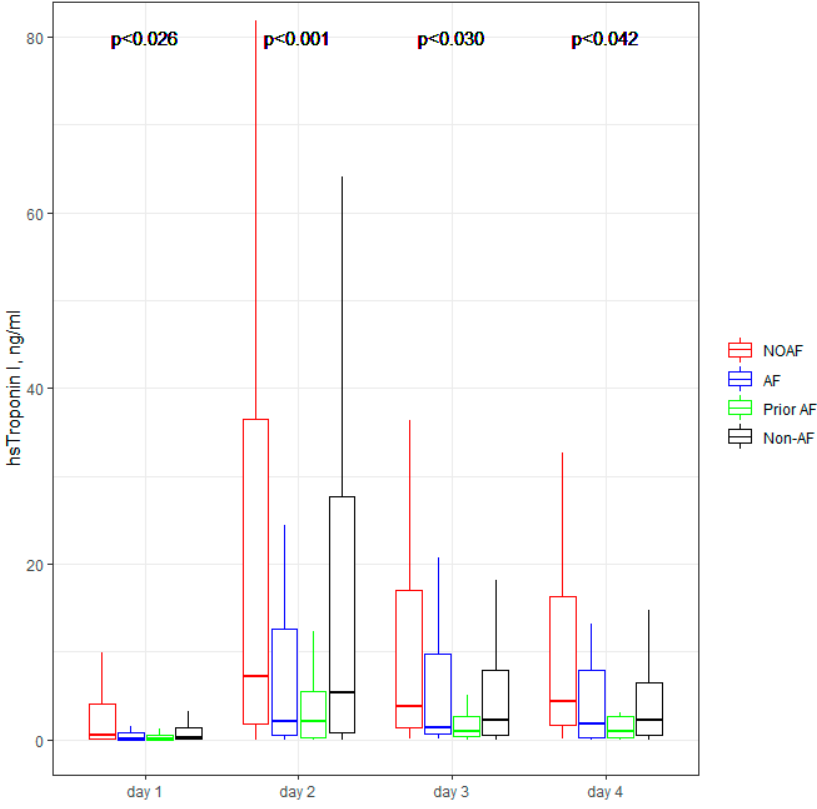
Figure 1. hsTnI concentration within the first four days of hospitalization. The center represents the median value. The upper and lower quartiles values are displayed with whiskers. p -values on the figure represent the group changes (the Kruskal–Wallis test). The time changes were calculated by the Friedman test and paired samples Wilcoxon test with Bonferroni adjusted ( p < 0.001). hsTnI—high sensitivity troponin I; NOAF—group of patients with any newly diagnosed AF that appeared during AMI hospitalization; AF—group of patients with a previously documented diagnosis of AF who additionally had AF during AMI hospitalization; Prior AF—group of patients with a previously documented diagnosis of AF who had not developed AF during AMI hospitalization; Non-AF—group of patients with no evidence of AF during AMI hospitalization and without the prior AF diagnosis.